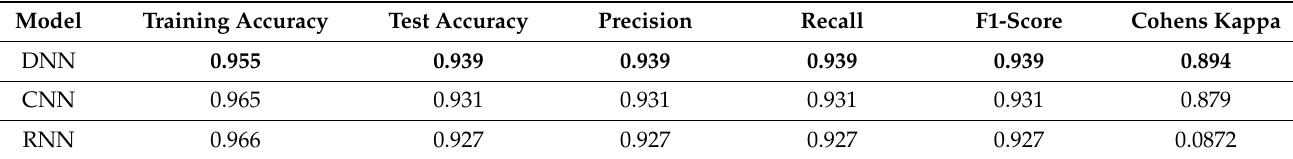
Table 8. Deep-learning model performances on training and test sets for three-class classification using all the features. The best performances are highlighted in bold.